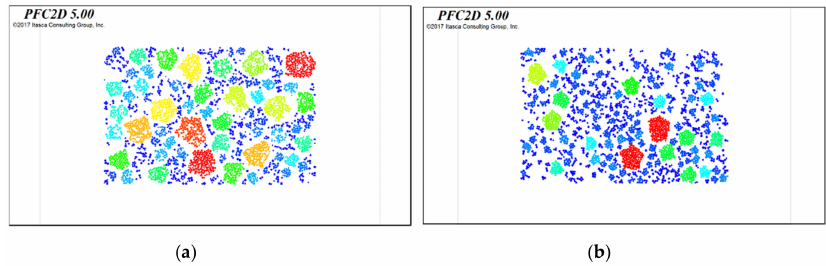
Figure 6. Distribution of coarse aggregate in the ( a ) OGFC and ( b ) AC PFC